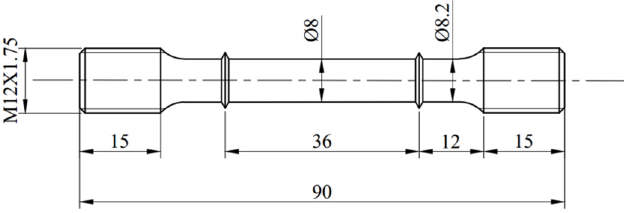
Fig. 2. Specimen geometry and dimensions for creep-ageing and tensile tests (units: